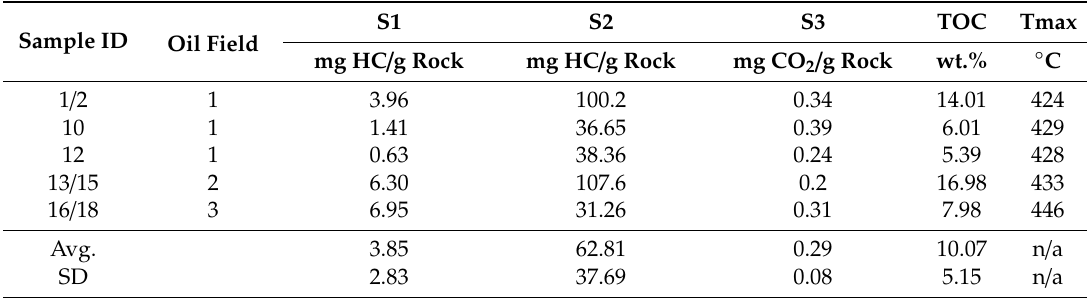
Table 5. Pyrolytic properties of samples before